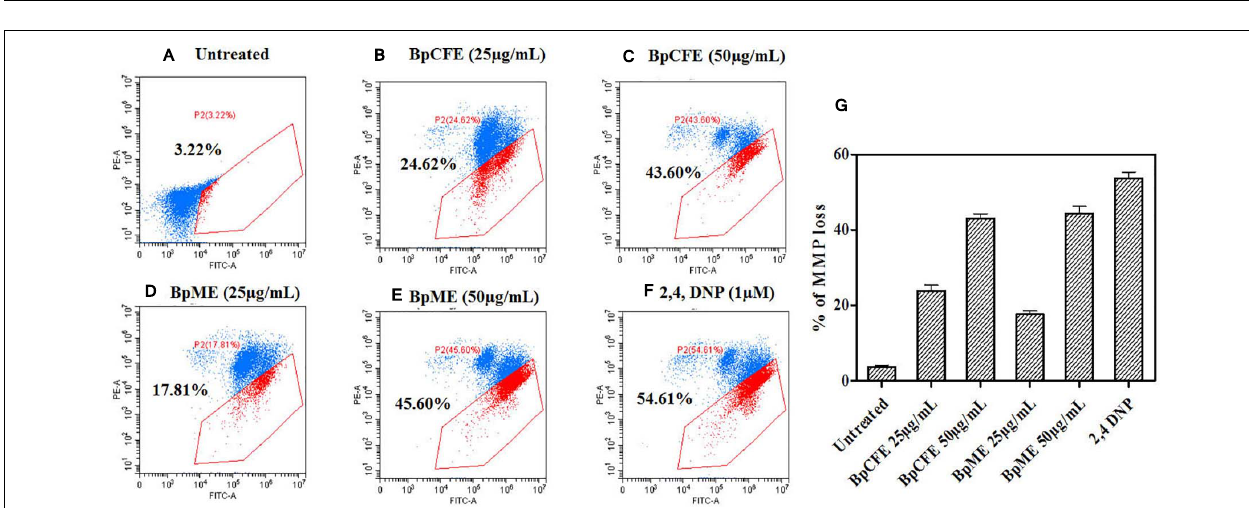
FIGURE 6 | Cytotoxic effect of Bp culture extracts on HeLa cells and estimated using PI staining by FACS analysis. (A) Untreated (B) culture filtrate extract (25 µ g/ml), (C) culture filtrate extract (50 µ g/ml), (D) mycelial extract (25 µ g/ml), (E) mycelial extract (50 µ g/ml), (F) paclitaxel (12 nM), and (G) bar diagram representing the distribution of cell death. The data are results from three independent experiments.